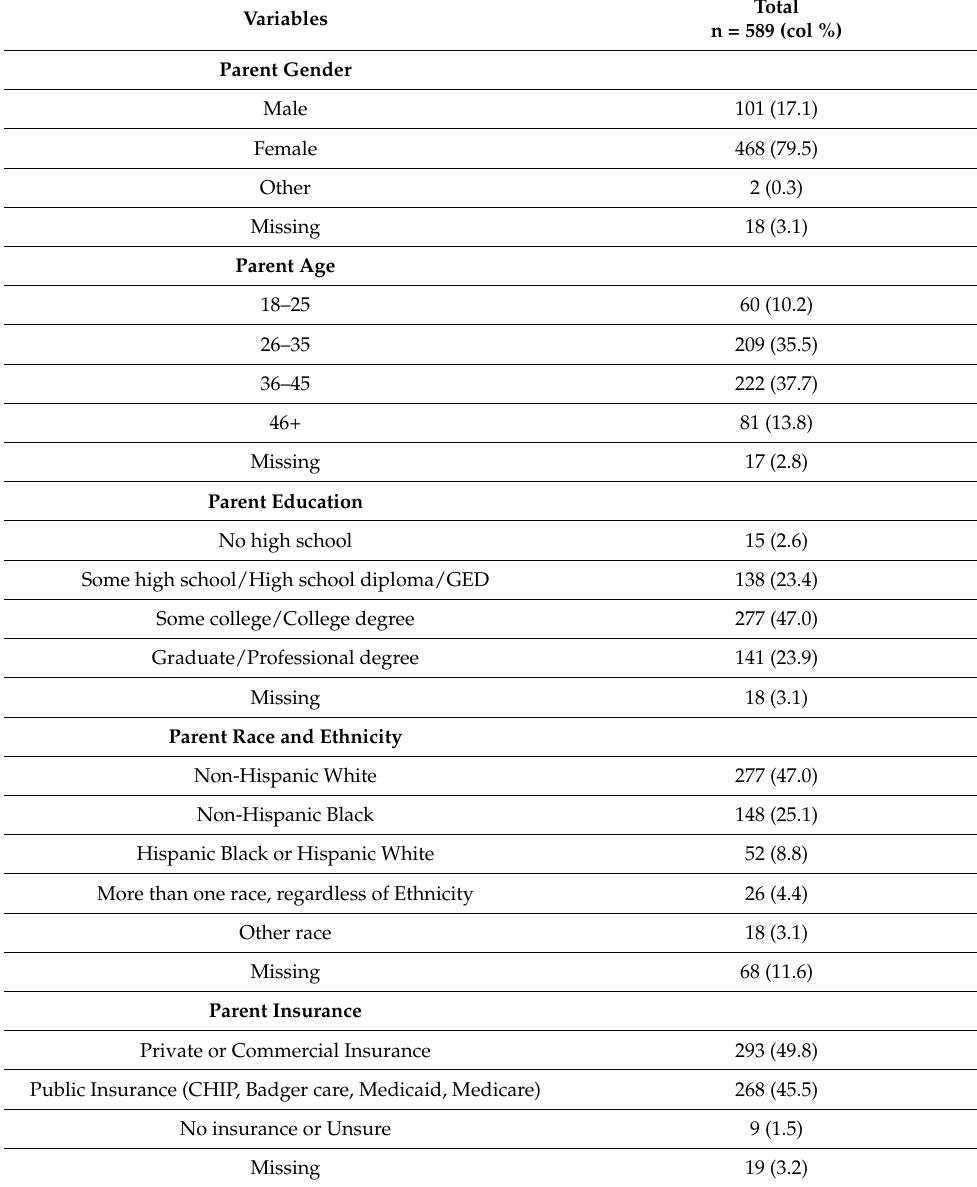
Table 1. Survey Participant